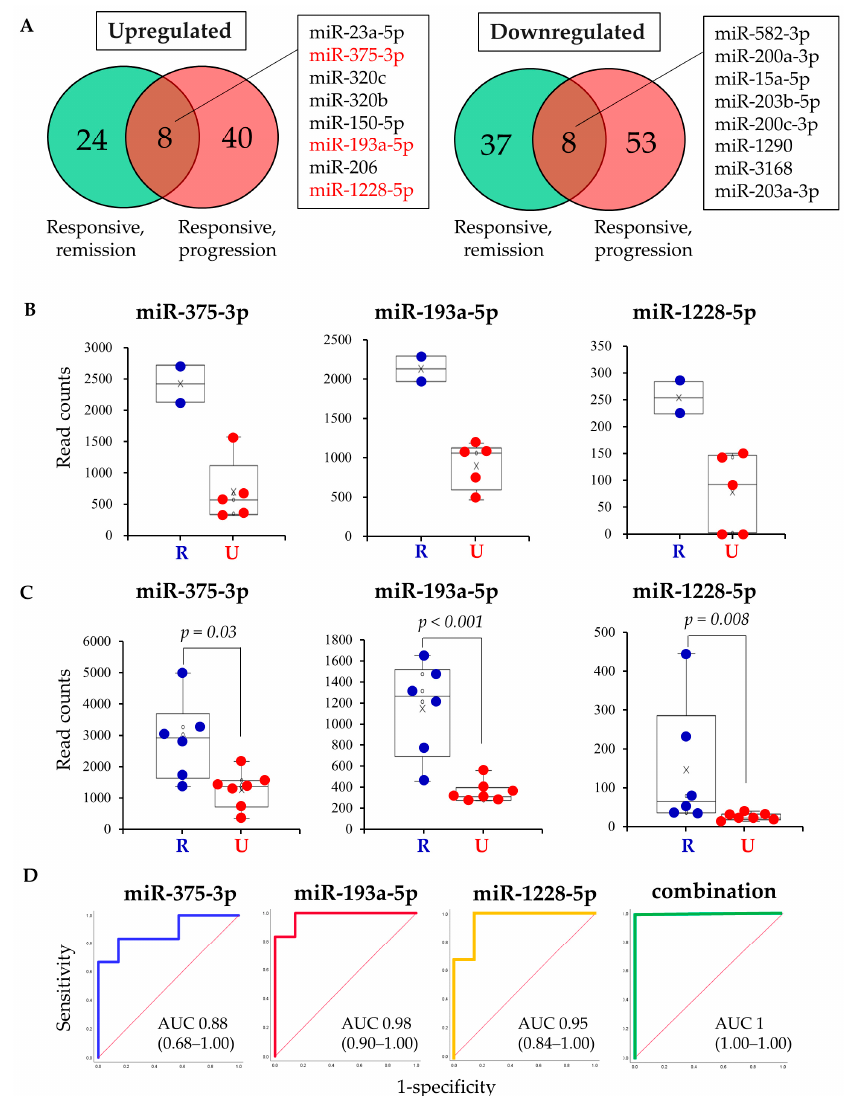
Figure 4. Extraction and evaluation of miRNAs as biomarkers. ( A ) Venn diagram showing commonly upregulated or downregulated miRNAs in Studies 1 and 2. Compared with each unresponsive subgroup, the number of miRNAs that were dysregulated in each responsive subgroup is shown. Responsive, remission: responsive subgroup in the remission group (Study 1); Responsive, progression: responsive subgroup in the progression group (Study 2); ( B , C ) box plots of expression of the three miRNAs in the progression and remission groups. The normalized read counts were compared using the Mann–Whitney U test. R: responsive, U: unresponsive; ( D ) ROC curves for detecting response to the GPC3 vaccine using each of the three miRNAs and combinations thereof.